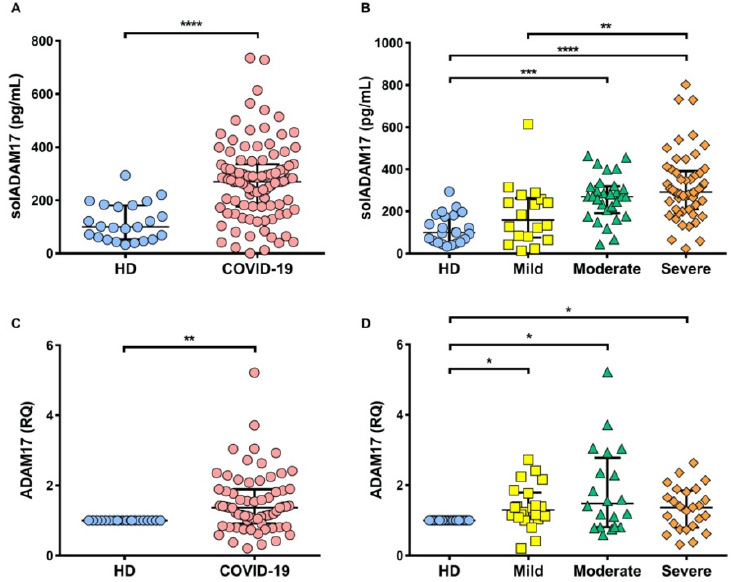
Figure 4. ADAM17 is increased at the protein and transcriptional levels for COVID-19 patients. ELISA assay sandwich was performed comparing healthy donors (HD) against the COVID-19 group ( A ) and comparing COVID-19 groups (HD n = 23, mild n = 19, moderate n = 29, and severe n = 53). ( B ) in both cases, solADAM17 was increased. Relative quantification (RQ) of ADAM17 was evaluated by qRT-PCR from PBMC of HD and COVID-19 patients. A comparison against HD ( C ) and between COVID-19 groups ( D ) showed that ADAM17 gene expression was increased (HD n = 10, mild n = 22, moderate n = 20, and severe n = 25). The Ct values of ADAM17 were normalized with the endogenous control genes 18S rRNA, and the relative expression of transcripts was quan- tified by the ΔΔ CT method. Data are presented as median with interquartile range, **** p < 0.0001, *** p < 0.001, ** p < 0.01, and * p < 0.05. 2.5. solTIM3 Level, But Not TGF- β , Is Increased in the Serum of COVID-19 Patients ADAM17 sheds several proteins on the cell membrane to deliver their soluble forms, including ACE2 that is the receptor for SARS-CoV2, T cell immunoglobulin and mucin domain 3 (TIM3), and transforming growth factor-beta (TGF- β ) [23,24].